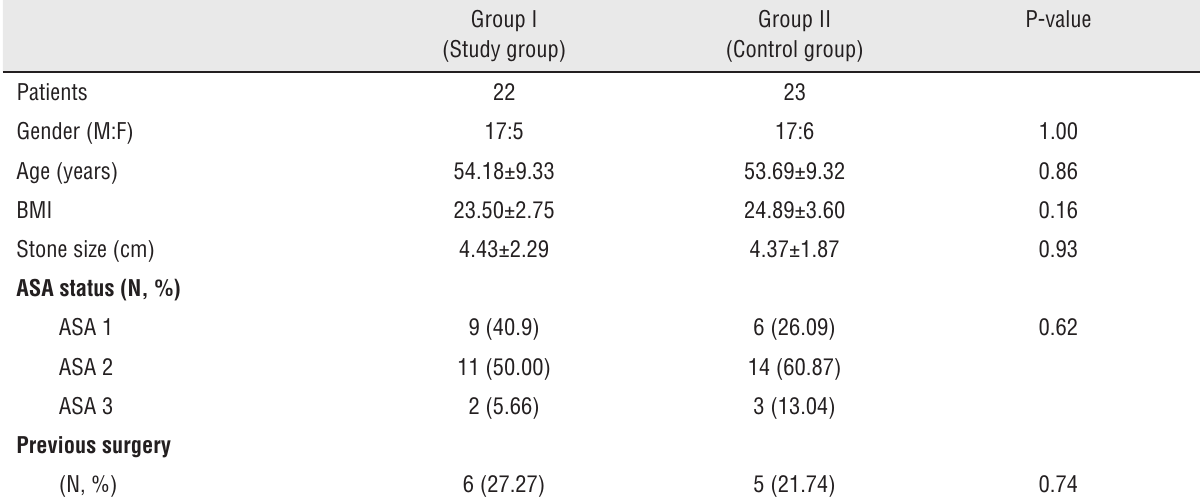
Table 3 - profiles of patients (supracostal access patients).